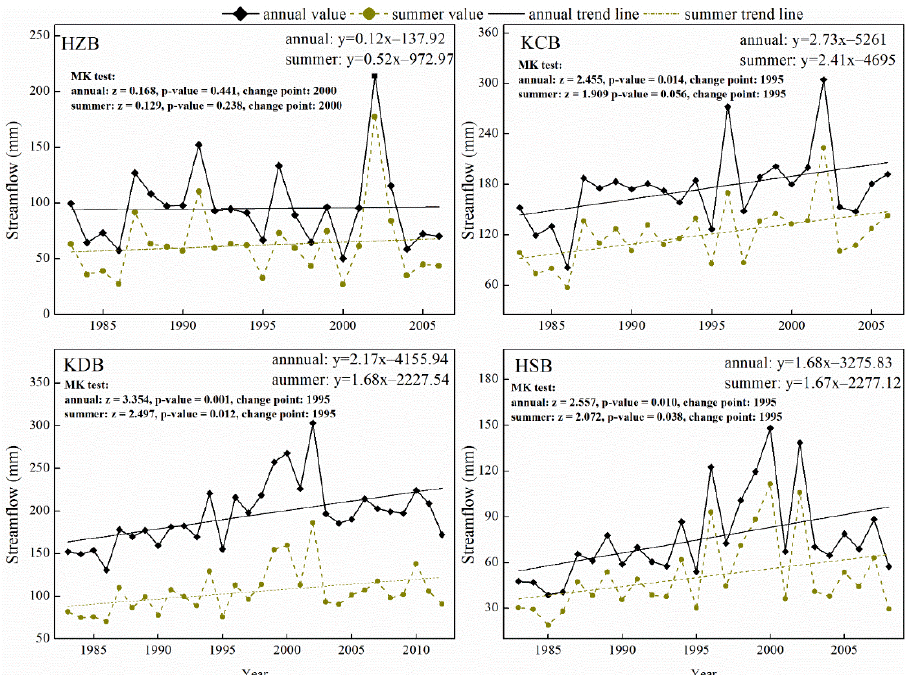
Figure 5. Variations of annual and summer streamflow of the four basins. Change trends of annual and summer streamflow have been determined by linear least-squares regression and the Mann– Kendall test.